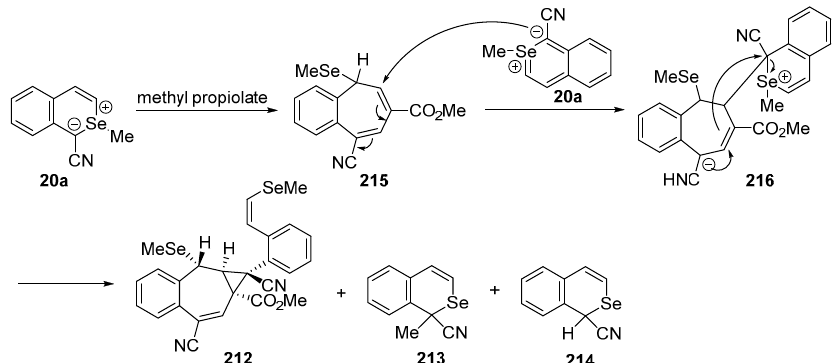
Table 15. Reactions of selenanaphthalene 20a with electron-deficient olefins. Entry Olefins (equiv.)